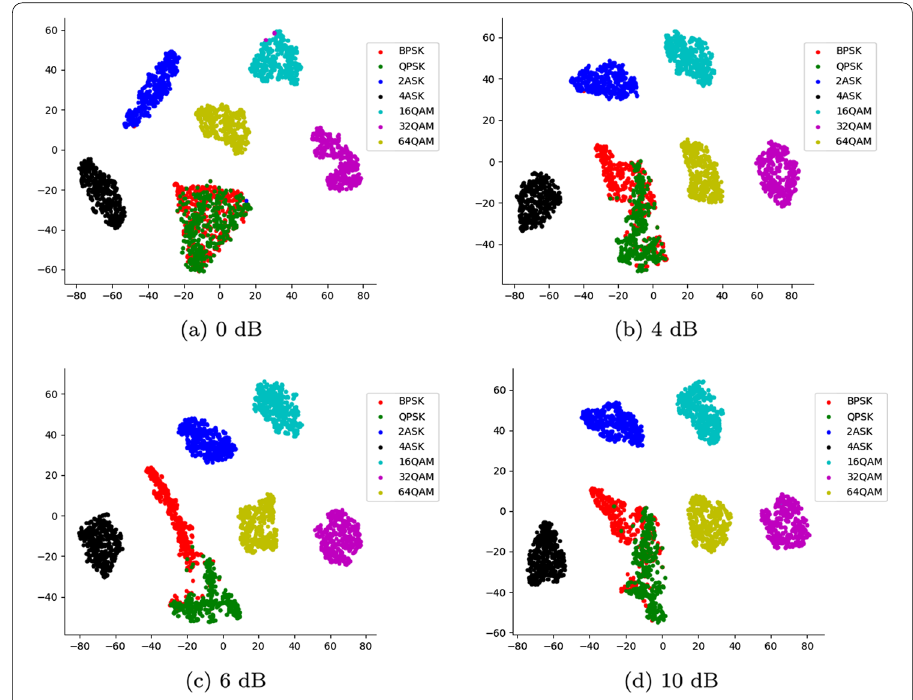
Fig. 8 The visualized t-SNE of Group 4 under different